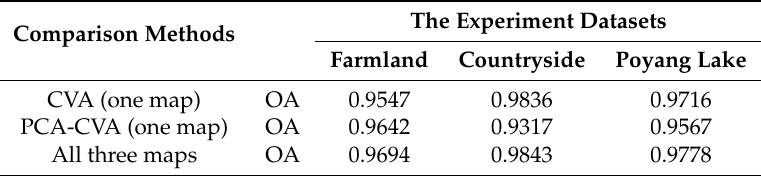
Table 4. Comparisons of different number of unsupervised change detection